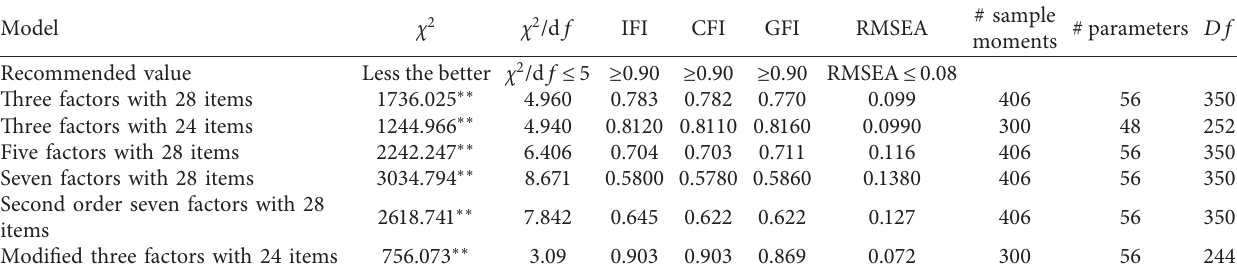
Table 5: GOF indices for the study